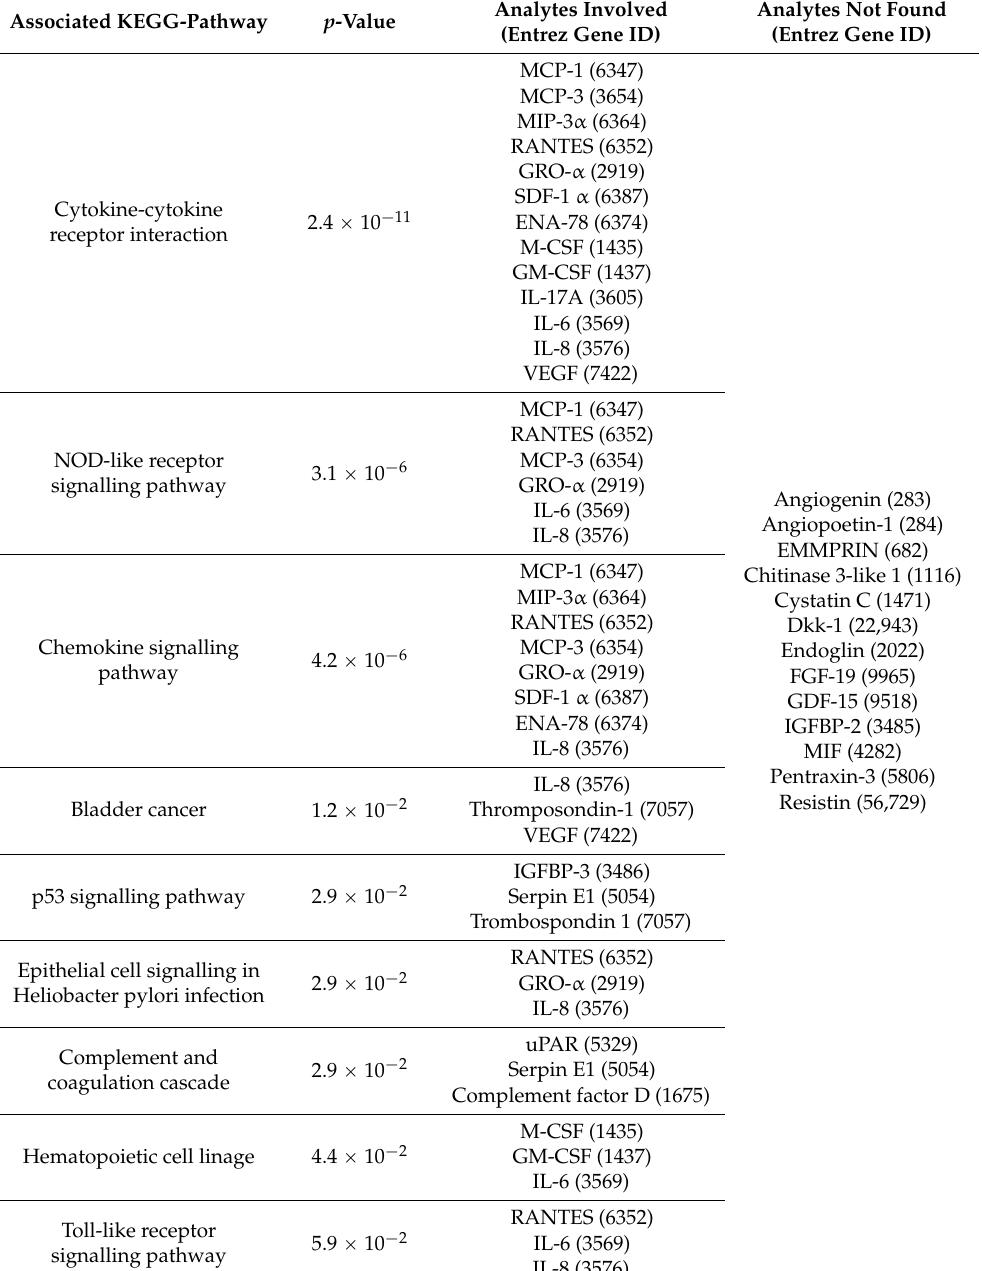
Table 2. Pathway analysis by the David database of high abundance analytes secreted by hepatocytic differentiated hbmMSC and hsubMSC (taken from Tables S3 and S4). Associated KEGG-pathways with p -values of significance as well as analytes involved and “not found” are shown,